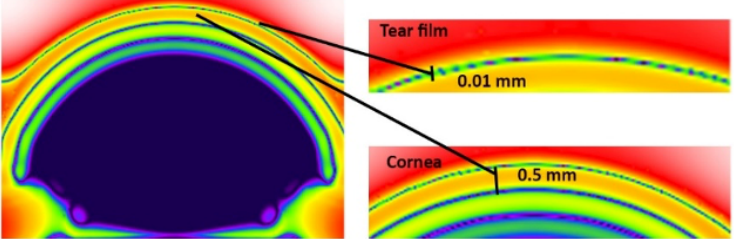
Figure 7. The detail of distribution of the E-field (in dB) in the anterior part of the eye